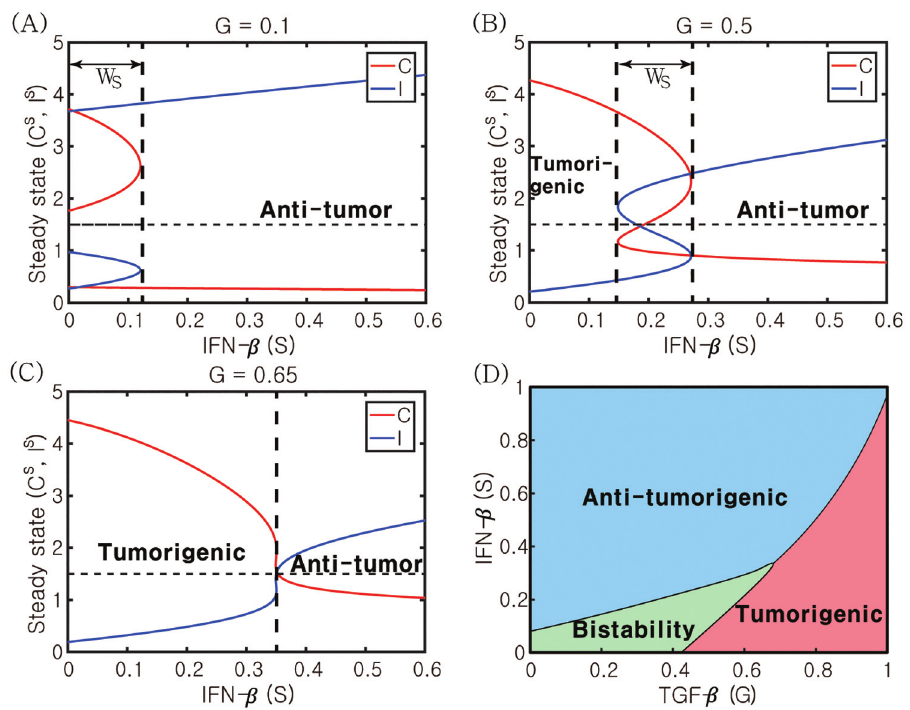
Fig 11. Dynamic change in response to the IFN- β signal. (A-C) Activities of N2- and N1-modules in response to IFN- β levels ( S ) when the TGF- β level is low ( G = 0.1 in (A)), intermediate ( G = 0.5 in (B)), and high ( G = 0.65 in (C)). When the TGF- β level is low or intermediate, there exists a bi-stable window ( W S = { S 2 [0, 1]: S m � S � S M }) where both P and P coexist. (D) For a constant IFN- β signaling, the system transits from P t a is increased. On the other hand, for a fixed TGF- β level, an increase in S induces a transition from P the P -status. Other parameters are given in Table a